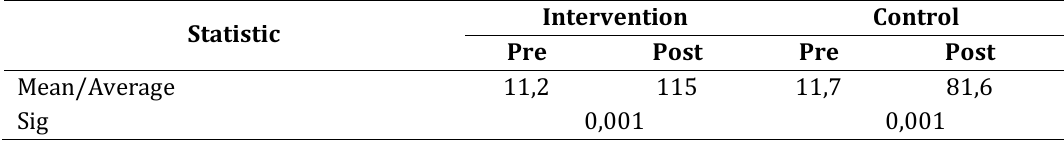
Normal Breast Milk Production in Postpartum in Treatment Groups and Control Groups Intervention Statistic